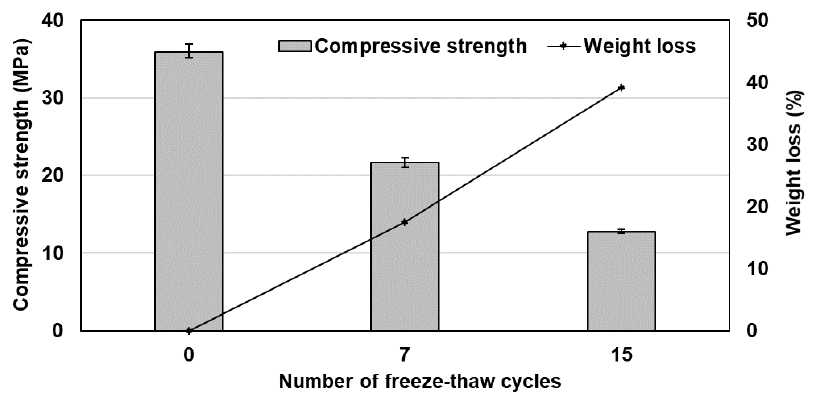
Figure 8. Compressive strength and weight loss of the MW/MK 0.3 AAM after subjection to 7 and 15 freeze–thaw cycles according to ASTM C1262-10.